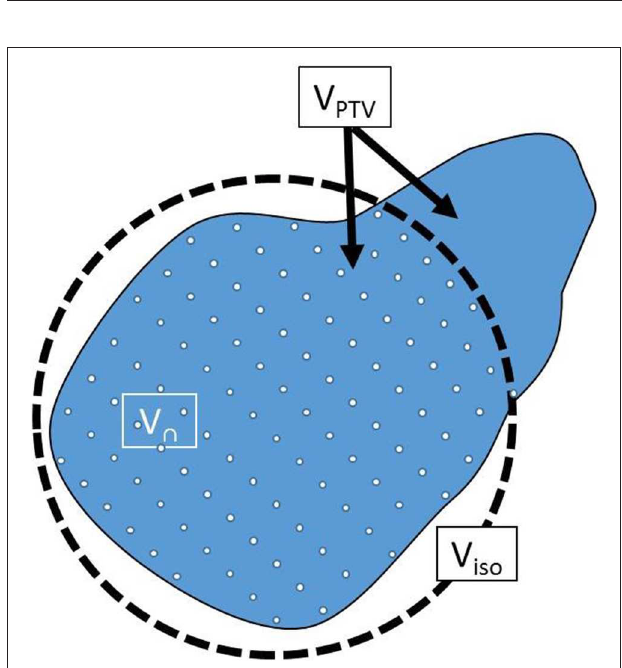
FIGURE 2 | Illustration of V n , V PTV, and V isod used in Equation (1).